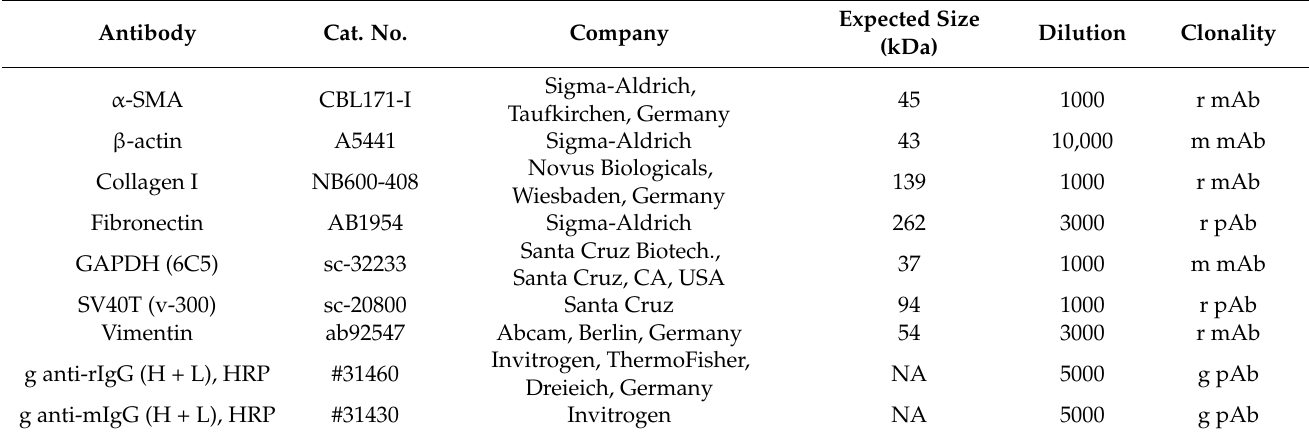
Table 1. Antibodies used for Western blot